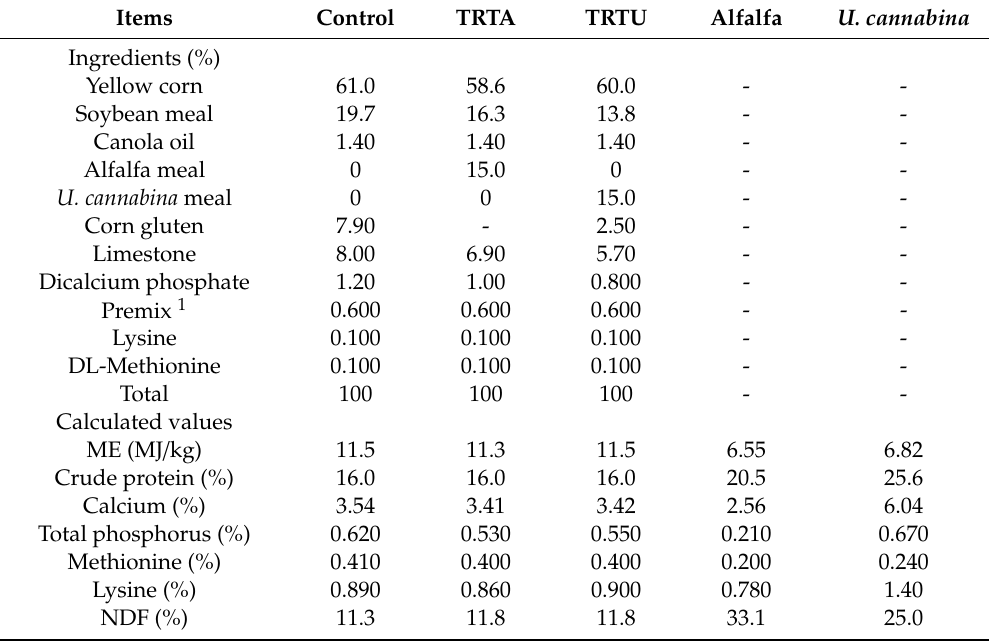
Table 1. Nutrient composition of alfalfa and U. cannabina , and the composition and nutrient levels of experimental diets for laying hens (based on dry matter). Items Control TRTA TRTU Alfalfa U.